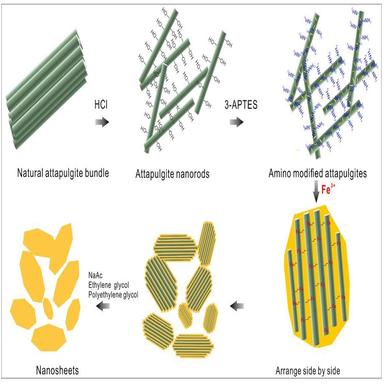
Schematic representation of the proposed mechanism on the formation of AT-NS.